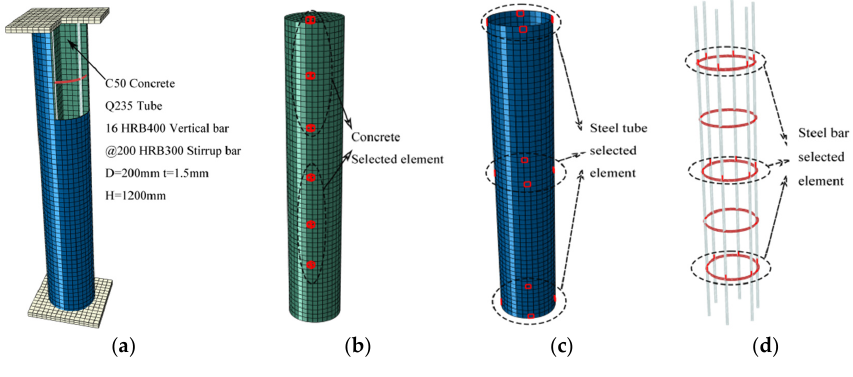
Figure 3. Finite element model of CTRC. ( a ) CTRC_200_6; ( b ) concrete element selection; ( c ) steel tube element selection; ( d ) steel bar element selection. Table 4. Constitutive model of FEM.